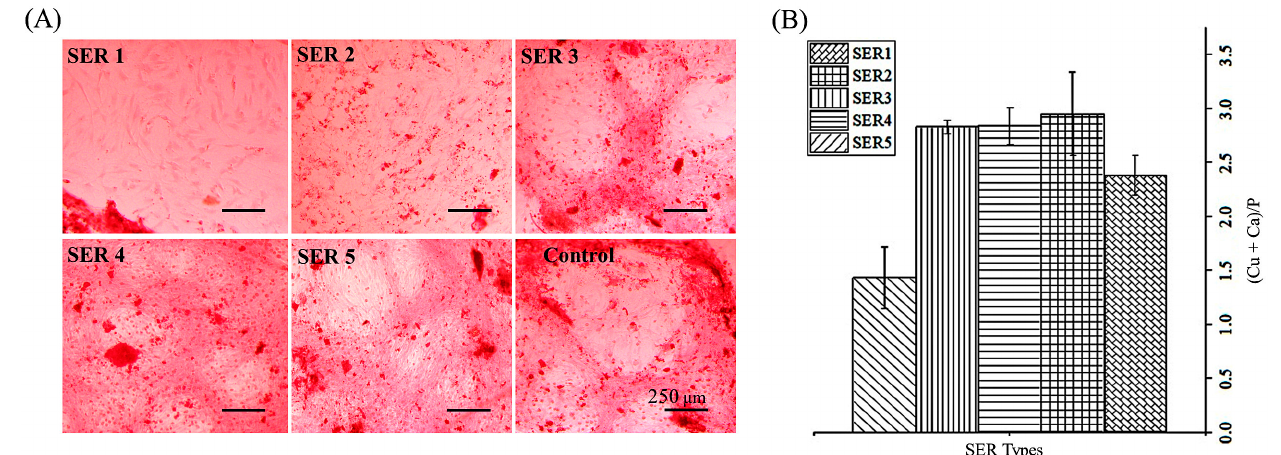
Figure 5. ( A ) Histological analysis (Alizarin Red S staining) of mineralization by hASCs treated with MOFs. Scale bar = 250 µ m. ( B ) Atom percentage ratio of calcium and copper to phosphate in